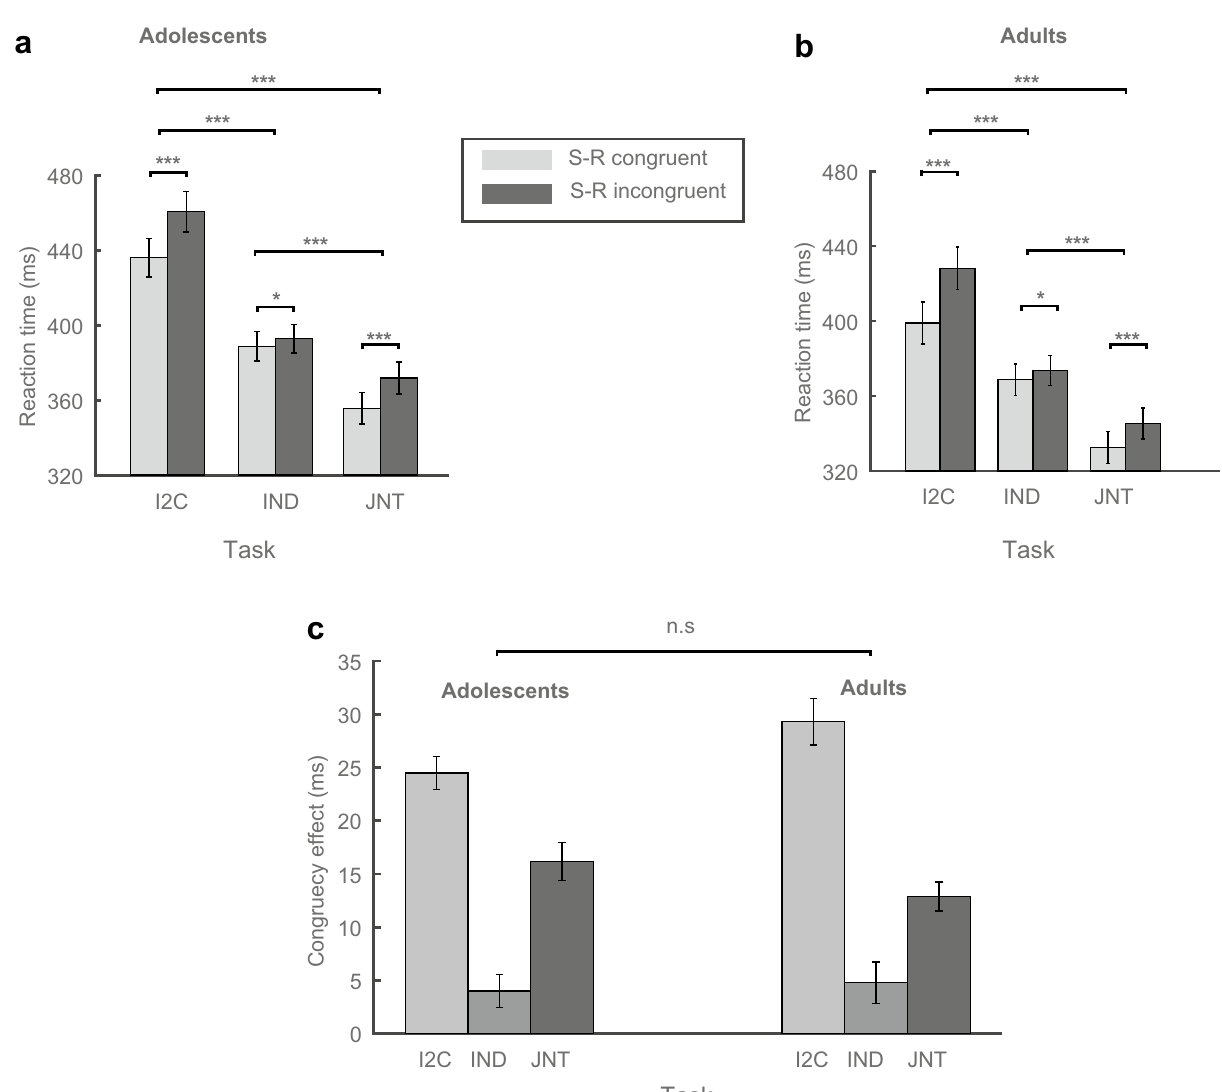
Figure 3. Reaction times and congruency effects for the tasks and the age groups. Top panels: Mean RT for different tasks and spatial stimulus–response (S–R) congruency for ( a ) adolescents and ( b ) adults. Bottom panel ( c ) mean congruency (Simon) effect measured as the RT in incongruent trials minus the RT in congruent trials for different tasks and the two age groups. Error bars indicate standard errors of the means. * p < 0.05, *** p <